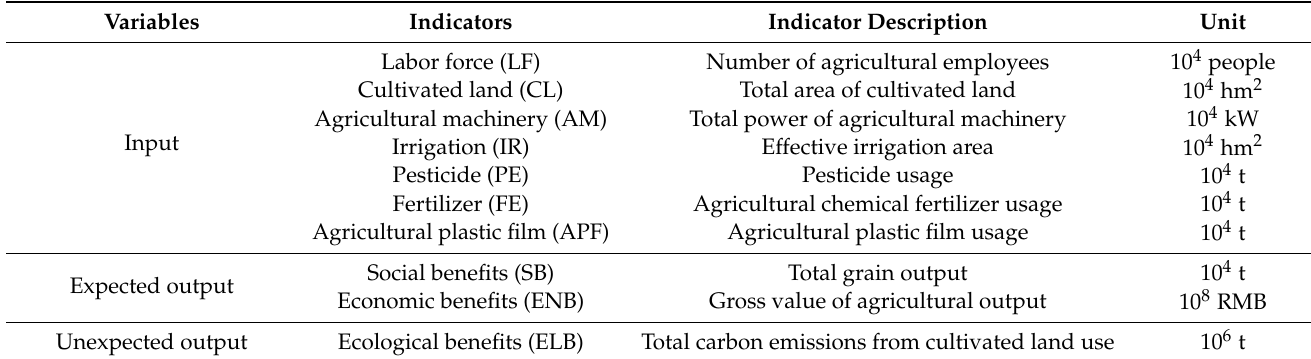
Table 1. Evaluation index system of CLUE.